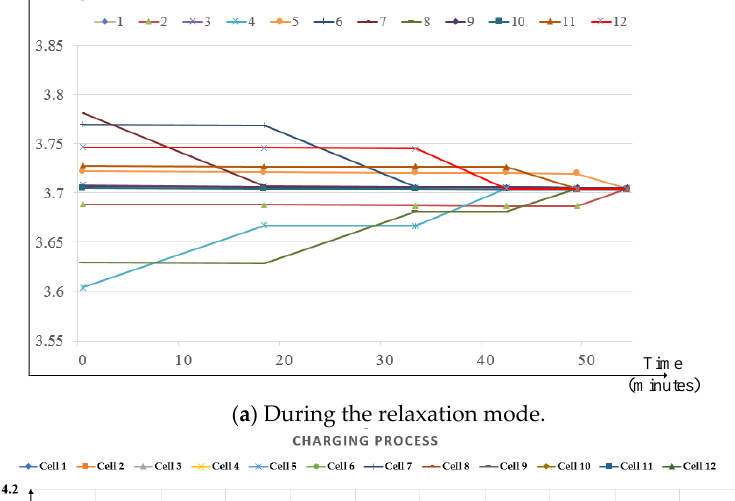
( c ) During the discharging mode. Figure 10. Cell balancing operation of the proposed circuit with twelve Li-ion battery cells.